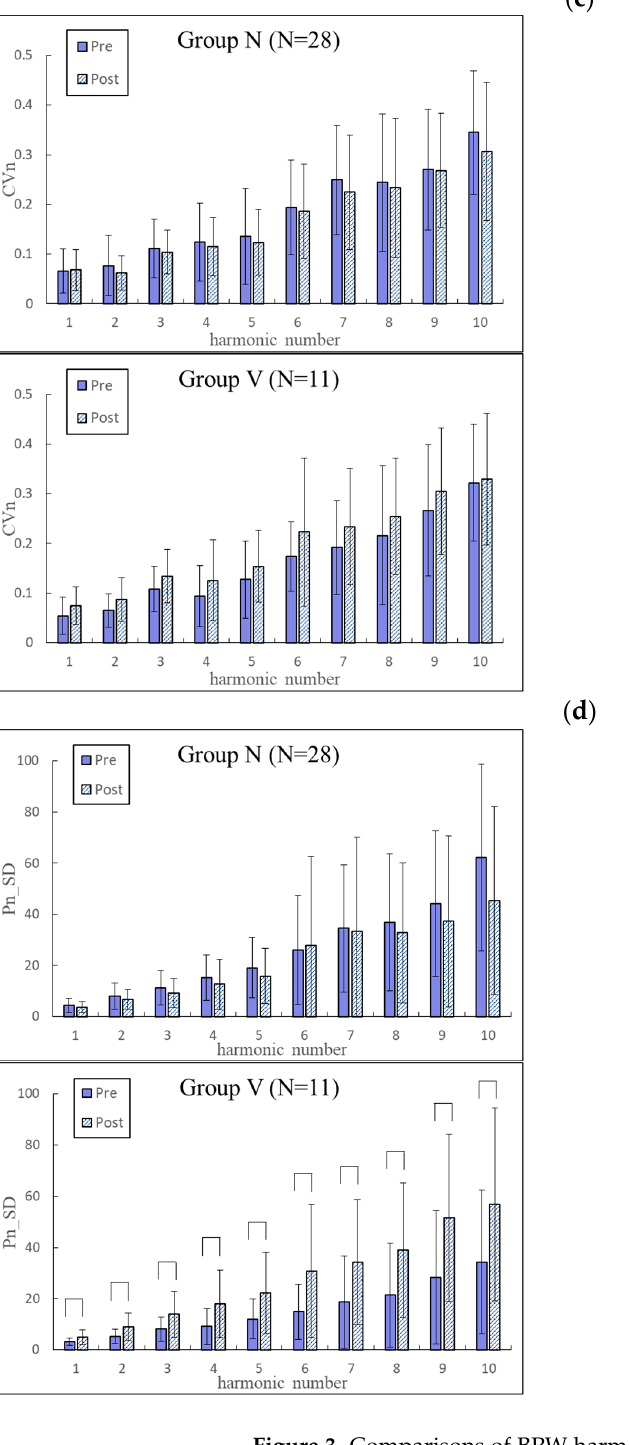
There were no significant changes in CV n and P n _ SD in the other groups.